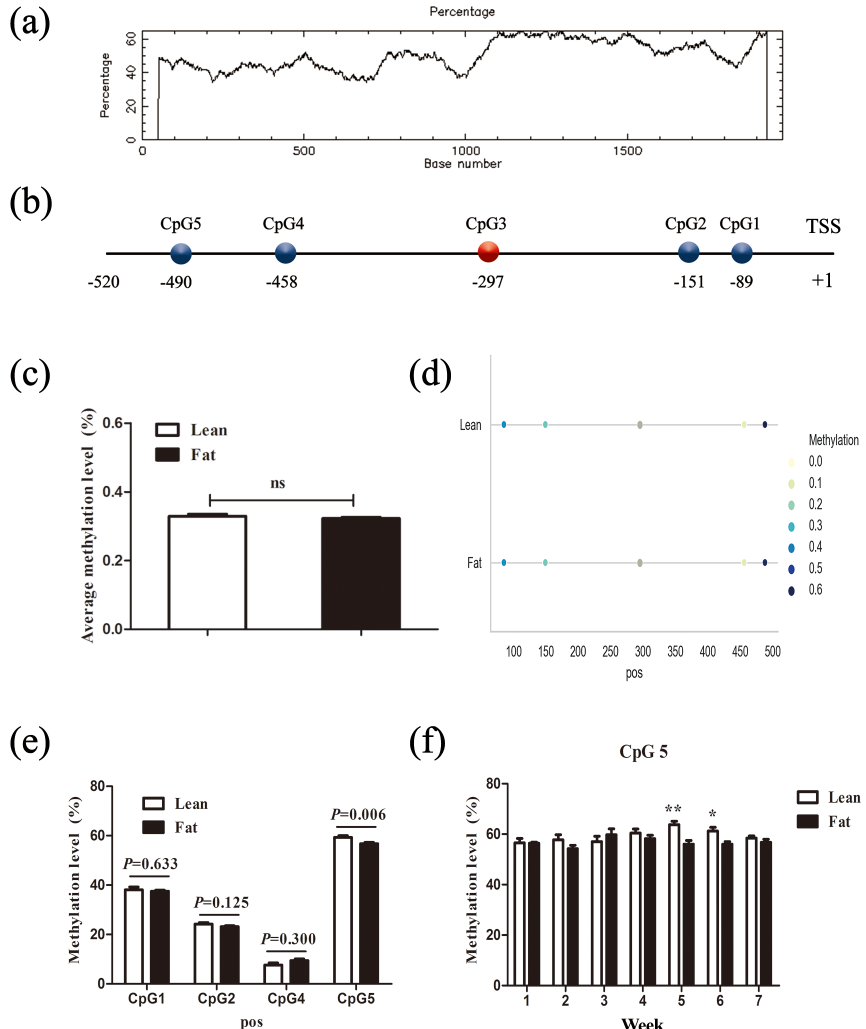
Figure 2. Comparison of CpG site methylation at the chicken PLIN1 promoter in NEAUHLF. (a) Search for CpG islands in the chicken PLIN1 promoter. Thresholds were GC > 50%, CpG observed/expected value > 0 . 6 and CpG island length > 200bp. (b) Schematic diagram of PLIN1 gene promoter. All numbered positions are relative to the adenine of the translation start site of chicken PLIN1 . Five CpG sites were found in the analyzed region, in which CpG3 (red) was not detected. (c) Average methylation level of promoter region in line and fat lines. Panels (d) and (e) show average methylation levels of the PLIN1 promoter CpG sites in adipose tissues of lean and fat broilers in all weeks ( n = 35). (f) Average methylation levels of CpG5 in adipose tissues of lean and fat broilers at 1–7 weeks of age ( n = 5). ∗ P < 0 . 05 and ∗∗ P < 0 .